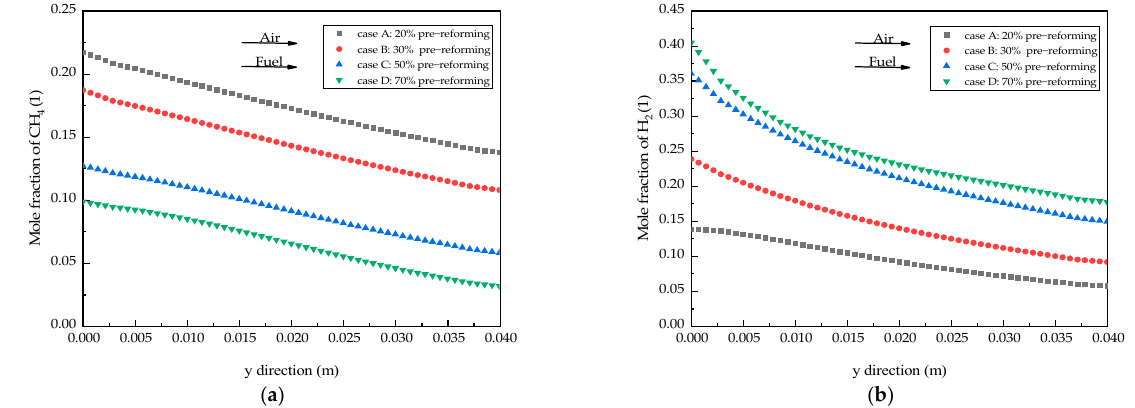
Figure 3. Distribution of mole fraction along the middle section of AAL in the forward direction of y-axis under different methane Pre-Reforming percentages. ( a ) CH 4 ; ( b ) H 2 .